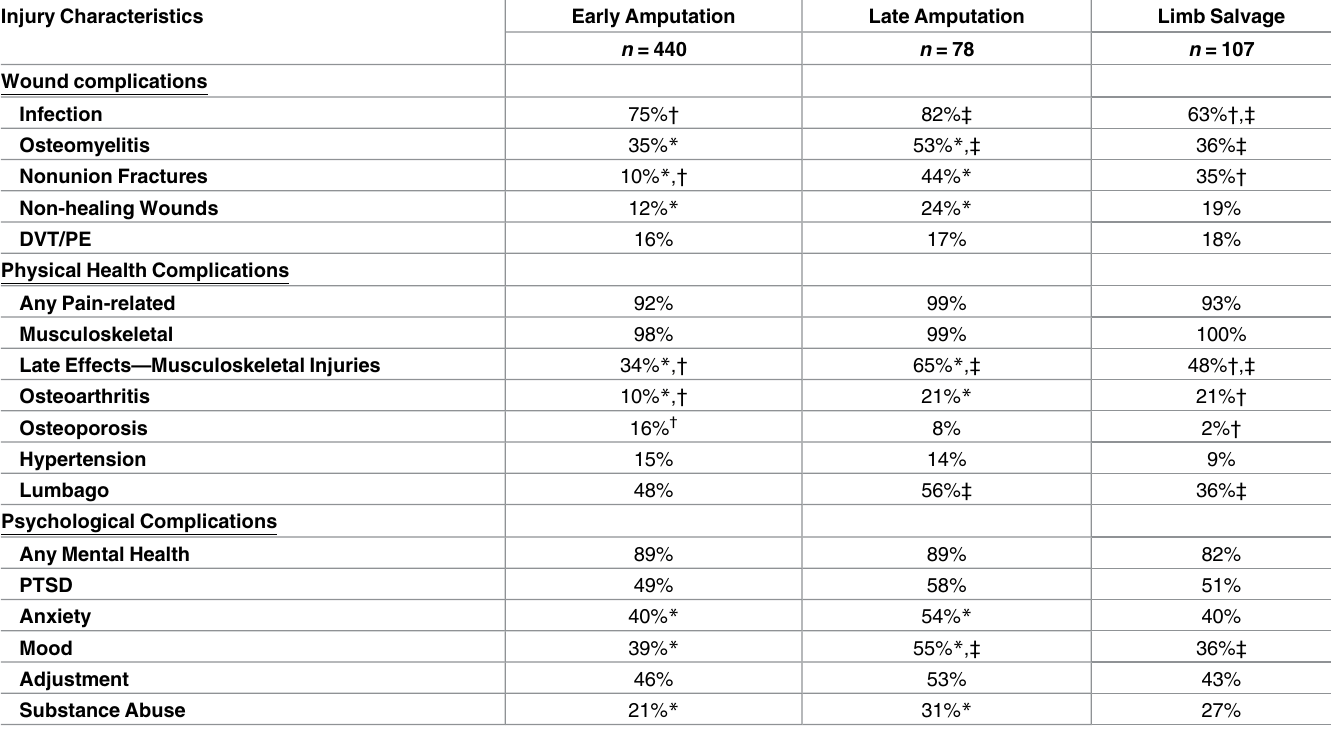
Table 2. Percent of Patients who Underwent Amputation and Limb Salvage with Wound, Physical, and Psychological Health Complications. Injury